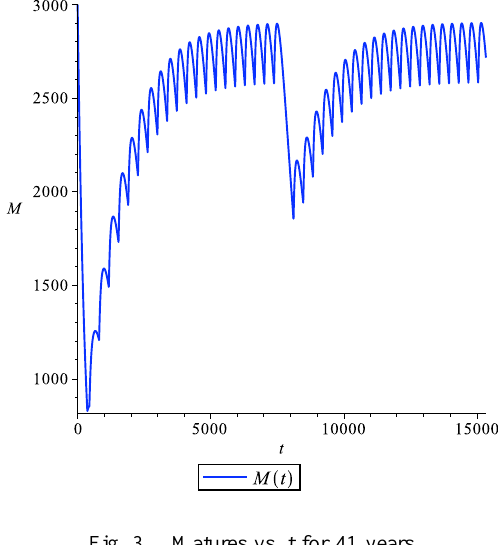
Fig. 2. Larvae vs. t for 41 years Fig. 3. Matures vs. t for 41 years